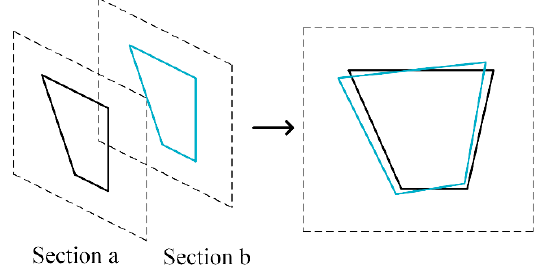
Figure 2. Non-standard grooves (shape distortion of groove).